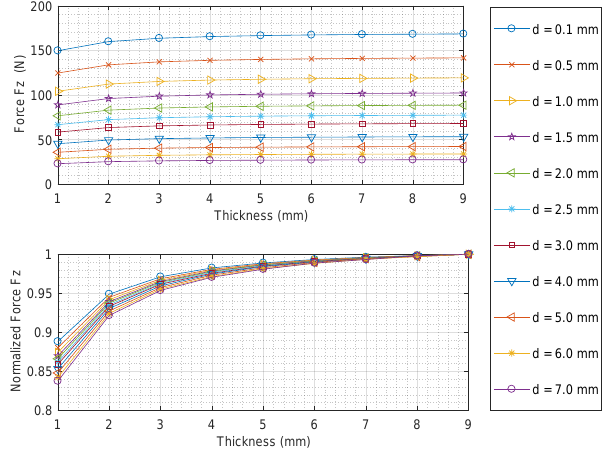
Figure 3. Magneto-static force predicted by the FE model with the large cylindrical